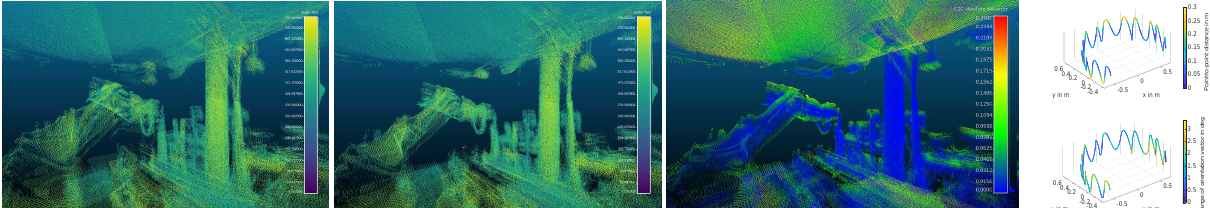
Figure 8. Linear Distortion: Top Left: Input point cloud. Top Middle: Corrected point cloud. Top Right: Error between corrected and reference point cloud. Bottom Left: Point to point distance between the corrected and original trajectory. Bottom Right: Change of orientation vector between the corrected and original trajectory.